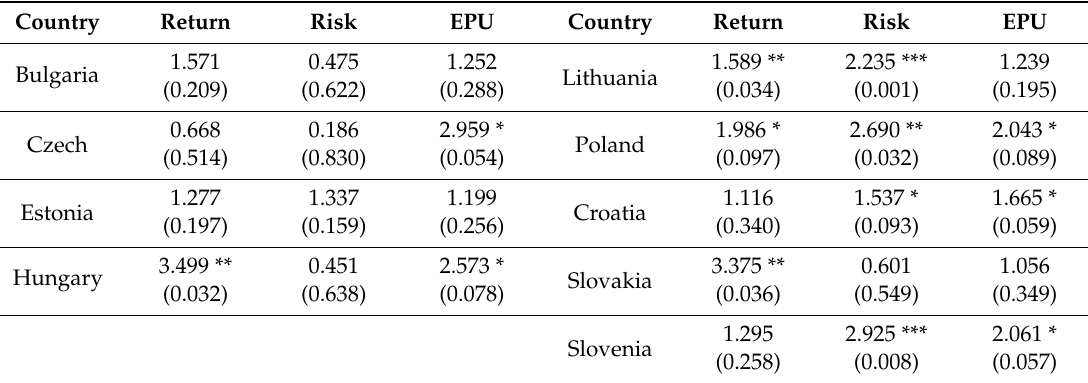
Table 4. Granger causality test